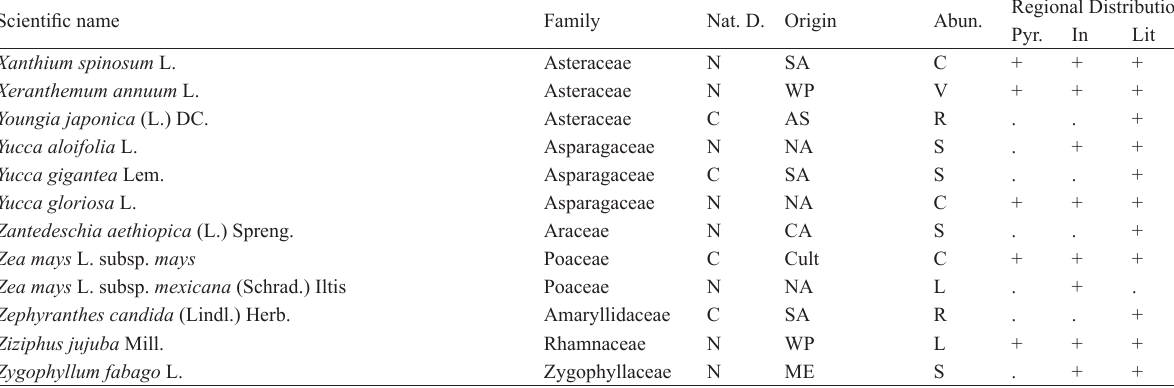
Table S1. Checklist of the Catalonian vascular alien flora. Data are presented in the table with the following information fields: taxon (arranged alphabetically, incl. hybrid taxa, which are also organized alphabetically); family; residence time (1: Before 1500 AD; 2: Between 1500 and 1900 AD; 3:Between 1900 and 1970 AD; 4: After 1970 AD); introduction pathway (A: Agriculture; G: Gardening; F: Forestry; T: Trade) and intentionality ofintroduction (A: accidental; D: